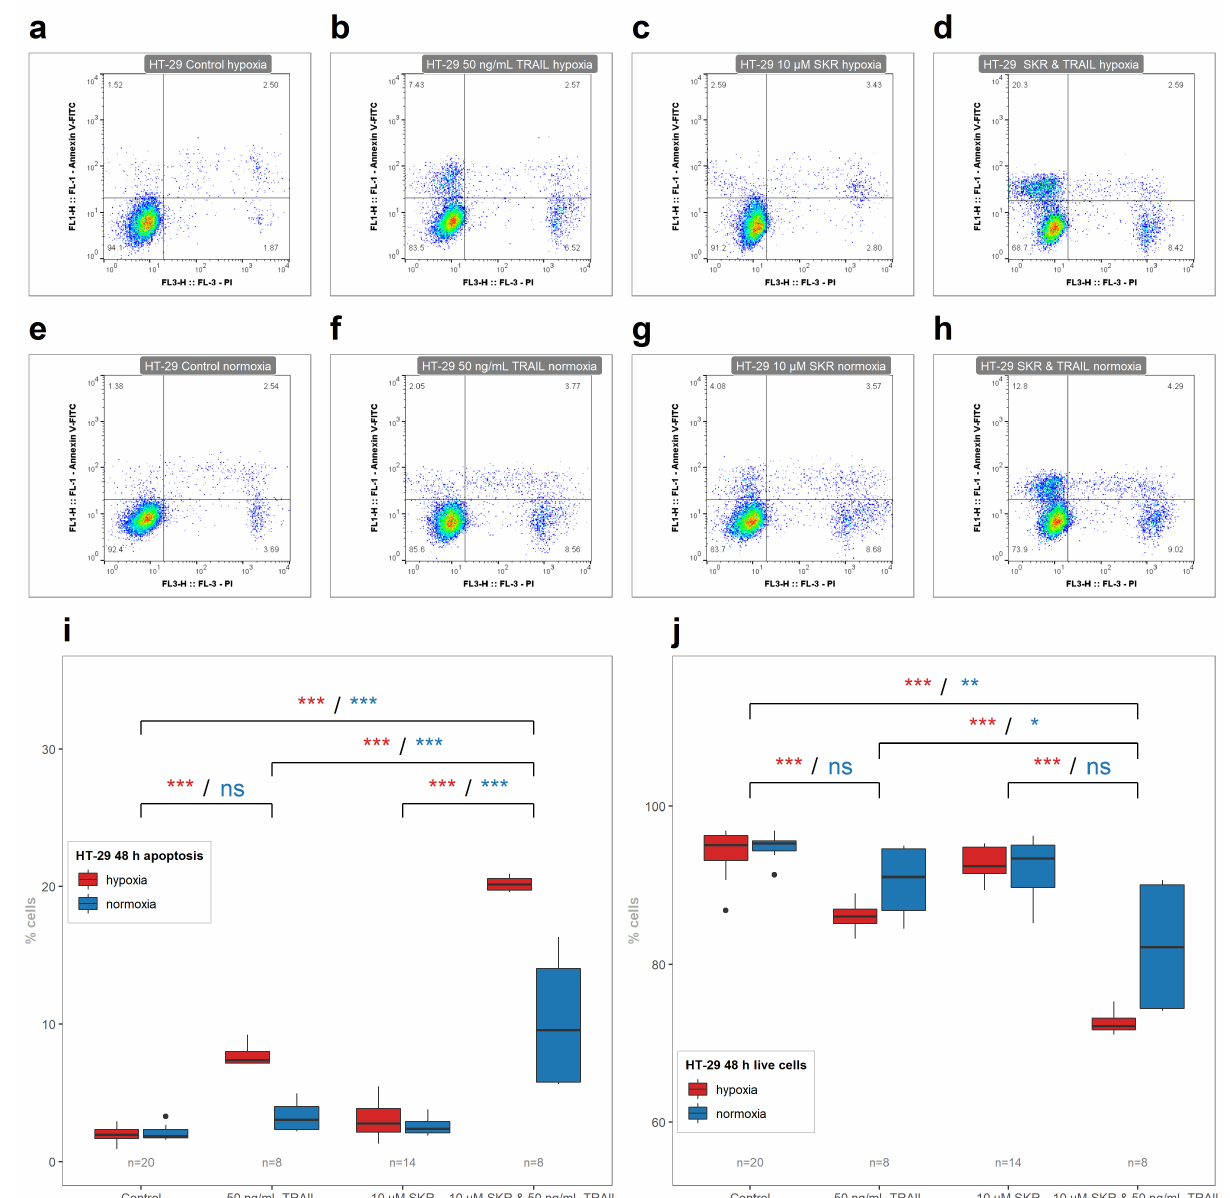
Figure 8. The effect of SKR in combination with TRAIL on the onset of apoptotic and live cells in HT-29 cell line. ( a – h ) Representative FACS plots of debris-free singlets after SKR and TRAIL treatment in HT-29 cell line. ( i ) Percentage of apoptotic cells after treatment with SKR and TRAIL after 48 h in HT-29 cell line. ( j ) Percentage of live cells after treatment with SKR and TRAIL after 48 h in HT-29 cell line. The experimental groups were compared with the matching control group or group, indicated with a line below marks. The color of the marks matches the cultivation conditions (hypoxia or normoxia). The number of samples (n) is noted in the plots. (* p < 0.05, ** p < 0.01, *** p < 0.001, ns—not